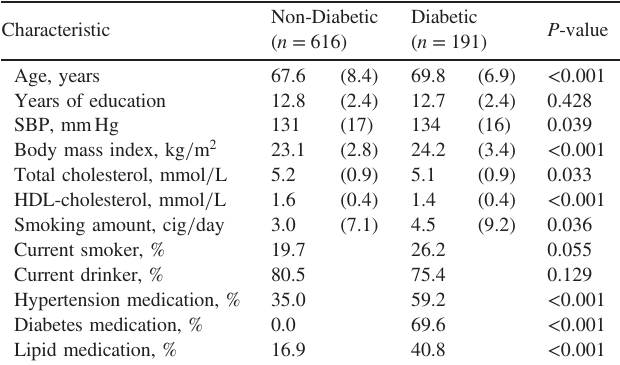
Table 1. Characteristics of men aged 46 – 81 years according to diabetes status in 2010 – 2014, Shiga, Japan ( n = 807) Characteristic